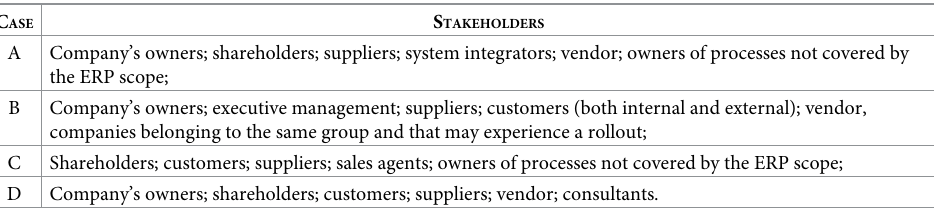
Table 7. Examples of indirect